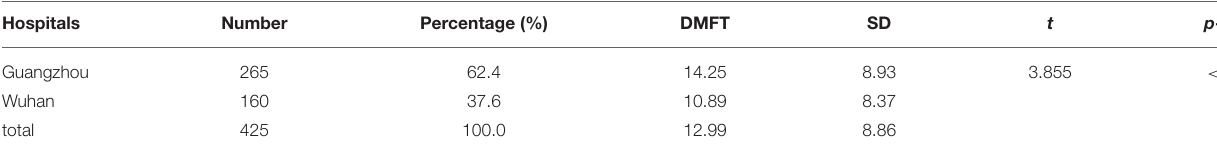
TABLE 1 | DMFT scores of elderly schizophrenia inpatients in different hospitals. Hospitals Number Percentage (%) DMFT SD t p